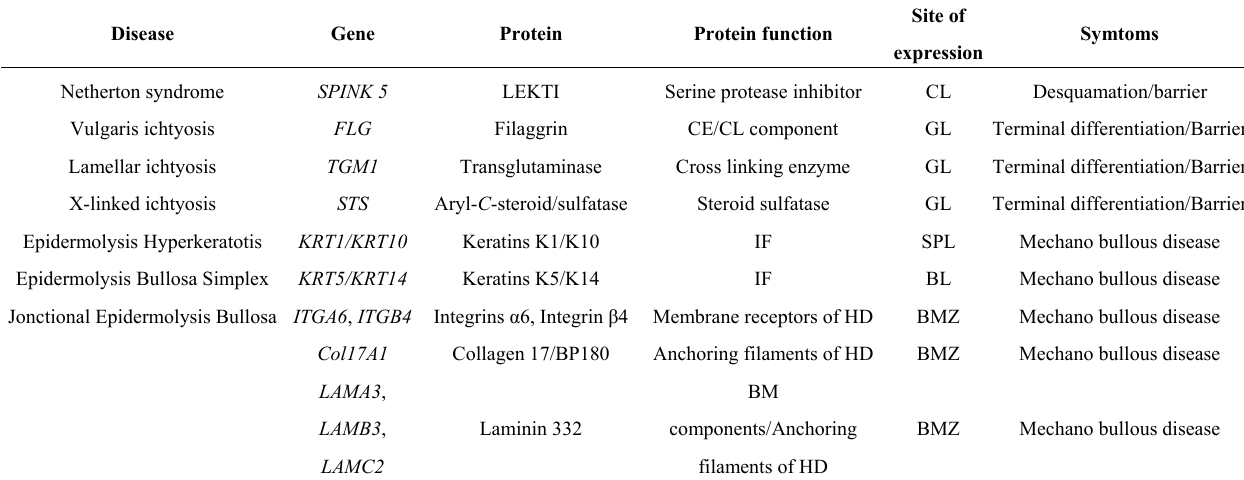
Table 2. Main human genodermatoses. CL, cornified layers; GL, granular layer; SPL, spinous layer; BL, basal layer; BMZ, basement membrane zone; BM, basement membrane; Kx, Keratin X; LEKTI, Lympho-epithelial kazal type related inhibitor; CE/CL, cornified envelope/cornified layer; IF, interfollicular; HD, hemidesmosome; XPx, xeroderma pigmentosum